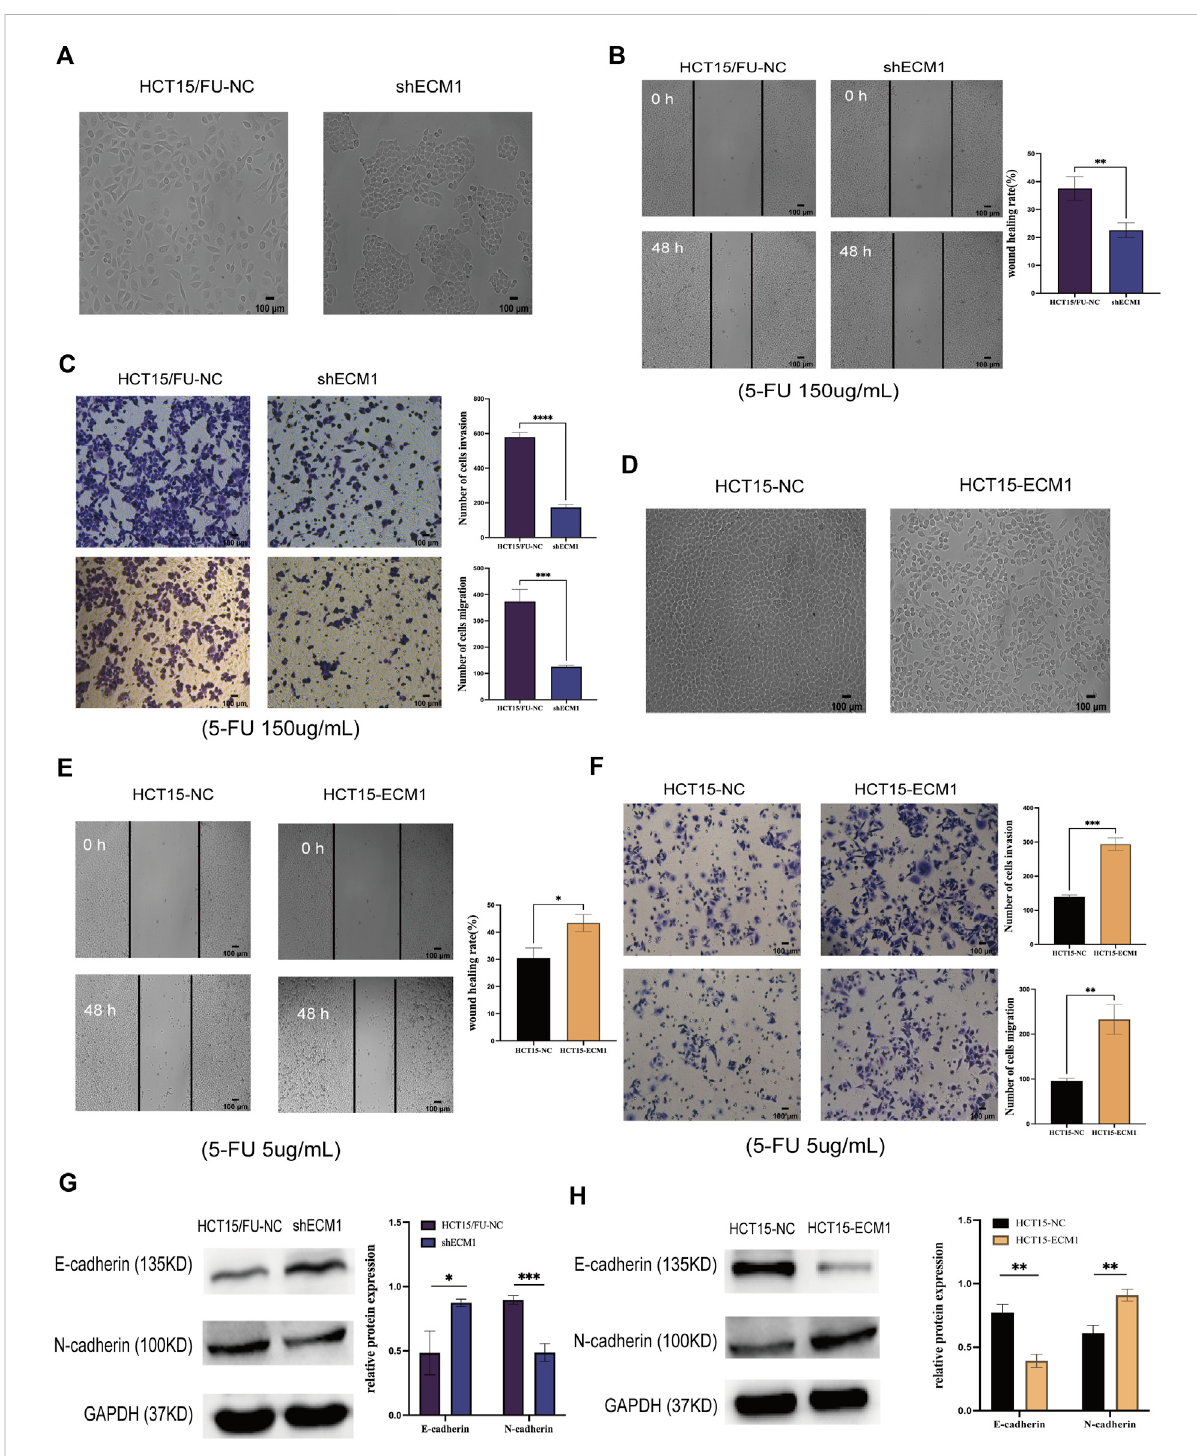
FIGURE 4 Knocking down ECM1 alters CRC cell EMTinduction. Themorphology oftherespective HCT15celltypeswas examined whenECM1 waseither knocked down (A) or overexpressed (D) . (B,C) A high dose of 5-FU (150 µg/ml) was used to treat HCT15/FU-NC and shECM1 cells, after which their migration/invasion was assessed through wound healing and Transwell assays. (E,F) A 5 µg/ml dose of 5-FU was used to treat HCT15-NC and HCT15-ECM1 cells, after which their migration/invasion was detected through Transwell and wound healing assays. (G,H) EMT-associated protein expression was detected following ECM1 knocked down or overexpressed. Data are means ± SD (* p < 0.5, ** p < 0.01, *** p < 0.001, **** p <